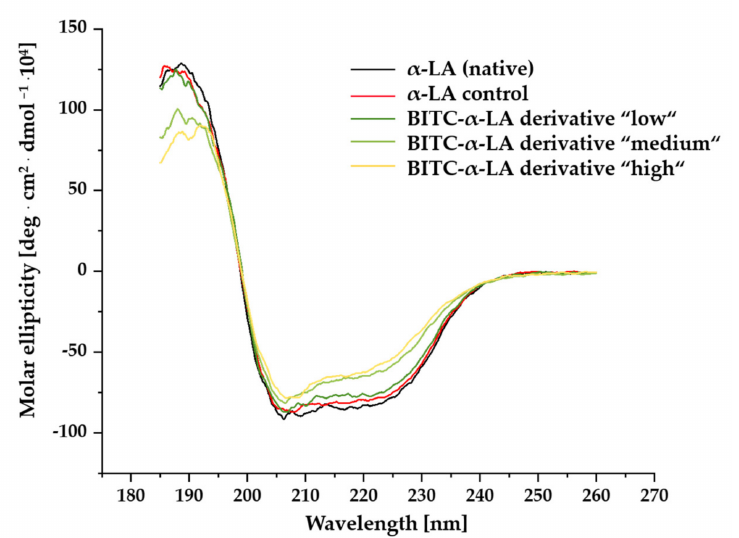
Figure 3. Far-UV CD spectrum of α -LA in the absence and presence of BITC.